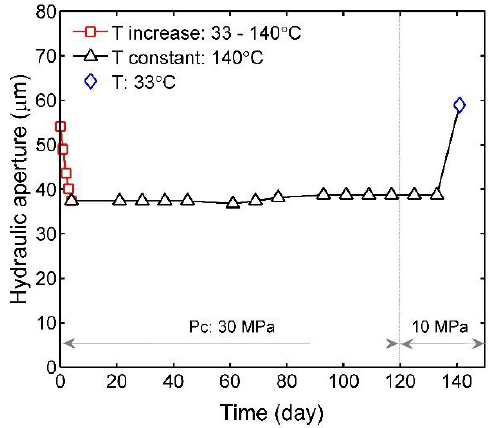
Figure 5. Evolution of hydraulic fracture aperture under different confining pressure and temperature conditions as a function of time during the long-term flow-through experiment (black triangles).